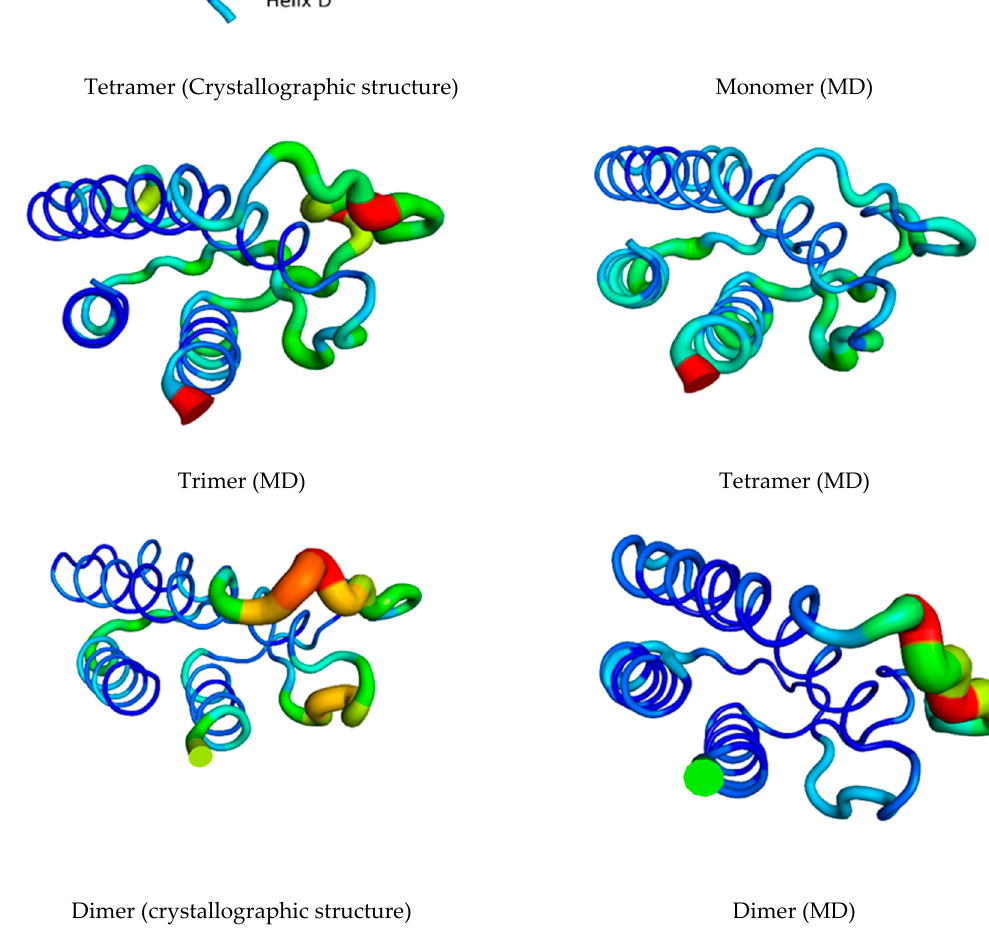
Figure 5. RMSF of C α carbon atoms of IL-15 residues in the various investigated multimeric models considering the last 100 ns of the MD simulations. In the sake of comparison, the corresponding figures have been prepared for IL-15 in the two crystal structures, the thickness of the line being related to the B factor values. The scale for the RMSF is from 0 to 4 Å, corresponding to B-factor values from 0 to 440 Å 2 (blue to red colors).